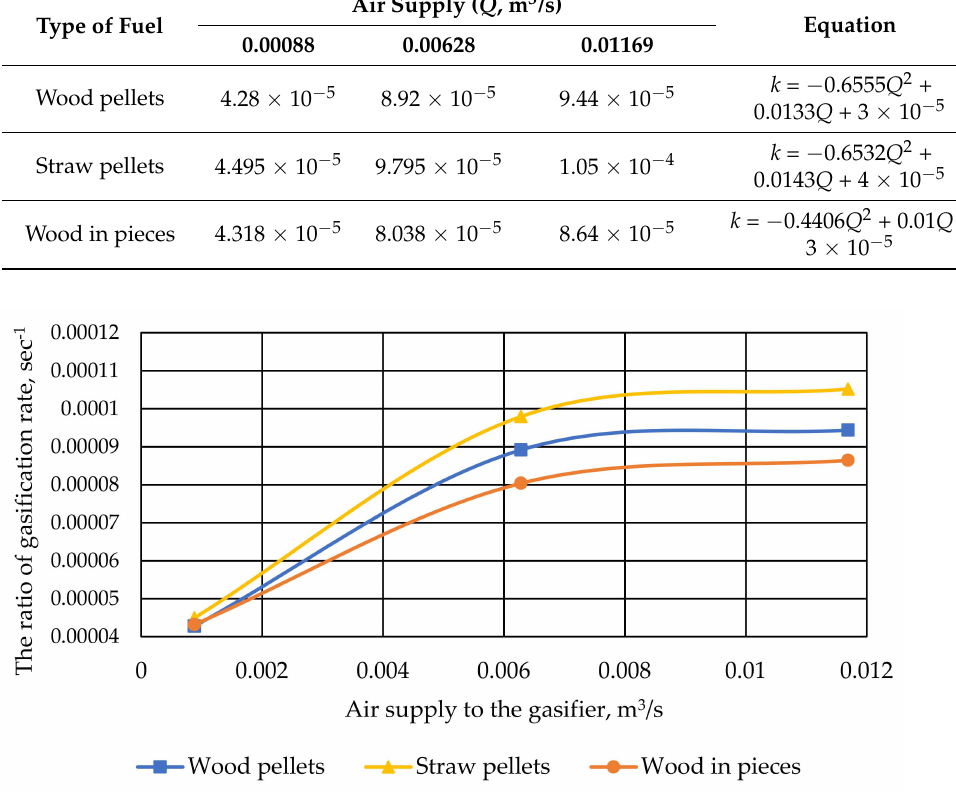
Figure 5. Change of the coefficient of gasification rate depending on air